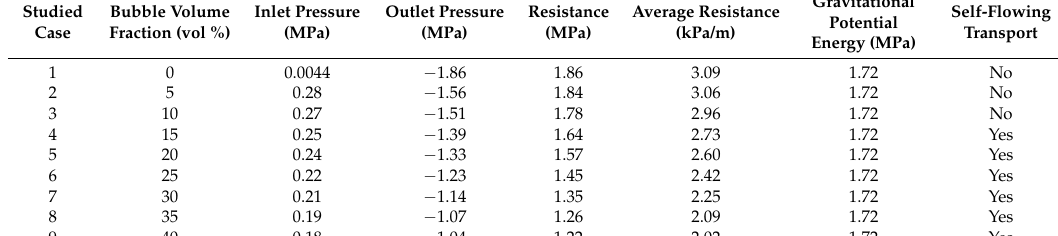
Figure 9. Total pressure profiles for various bubble volume fractions.